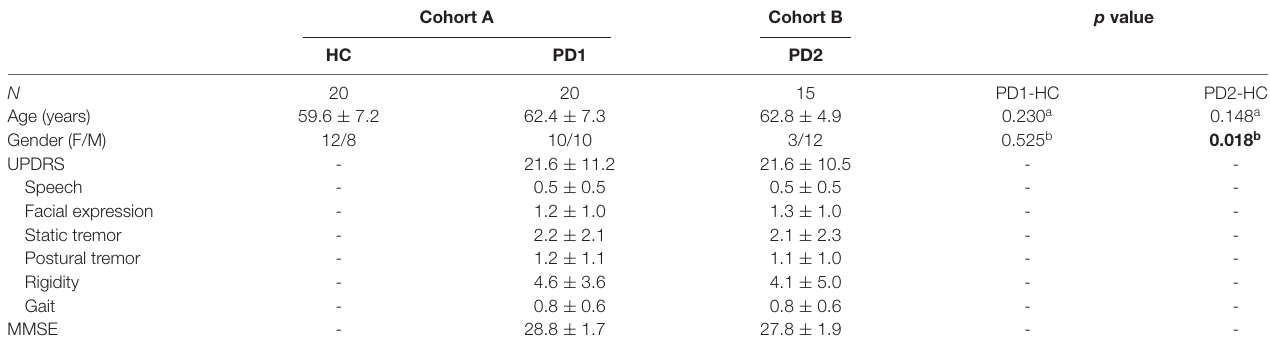
TABLE 1 | Demographic characteristics of PD patients and healthy